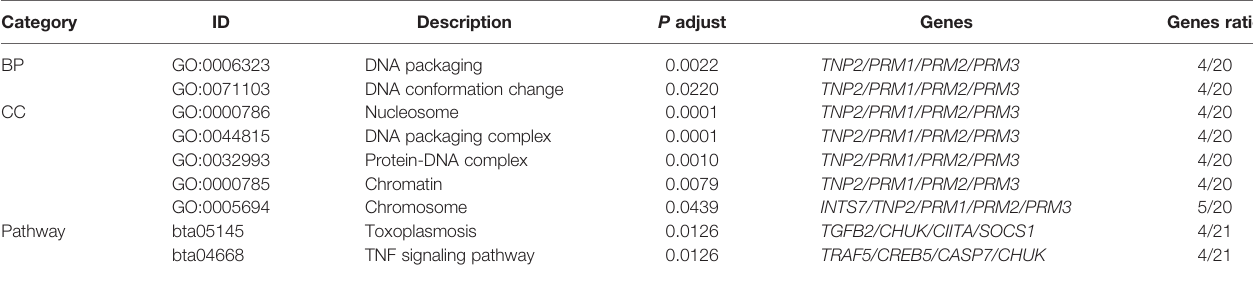
TABLE 5 | Results of the gene ontology and pathway analysis using the identi fi ed candidate genes. Category